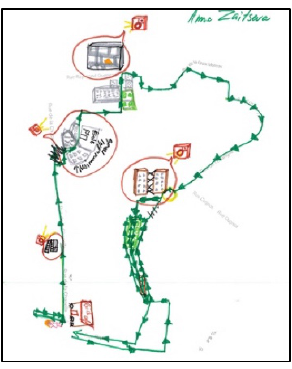
Figure 6. Example of sectorizations